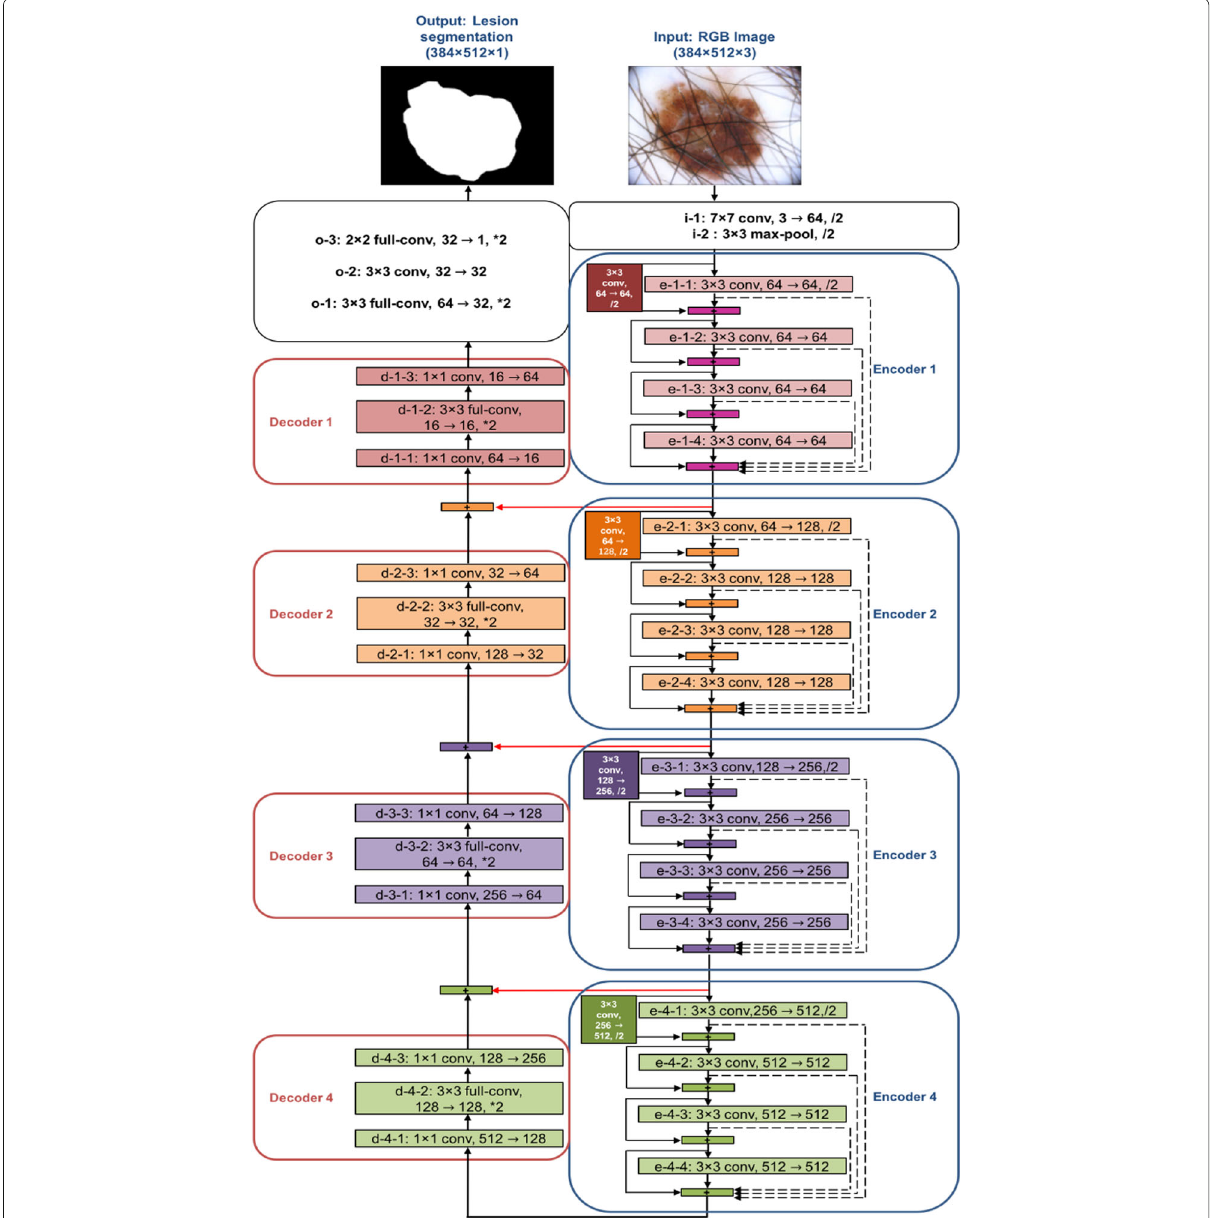
Fig. 3 DermoNet is composed of four blocks in the encoder and decoder, respectively. Black arrows show connectivity patterns in the network, while red horizontal arrows represent skip connections between the encoder and decoder